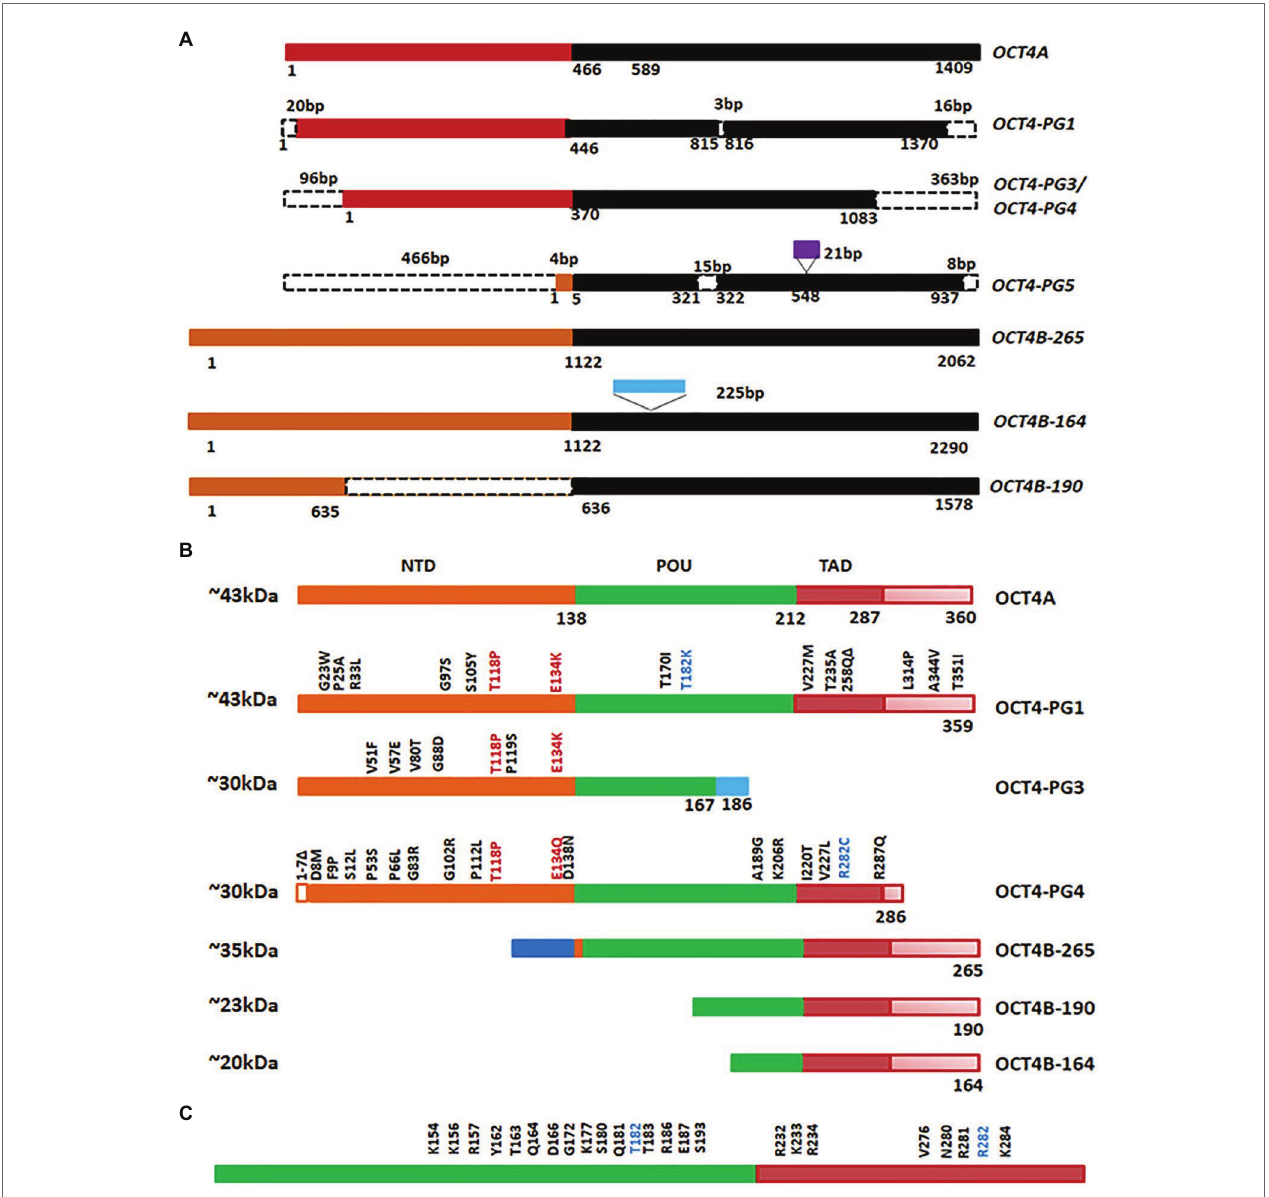
FIGURE 5 | Octamer binding transcriptional factor 4 (OCT4) variants in cancer. (A) The different isoforms and pseudogenes of OCT4 expressed in cancer at the RNA level. The conserved regions are shown in the same color. The dotted lines indicate absence of the region. The sequences inserted are shown in purple or blue boxes. (B) Protein expression of the variants. Conserved amino acid stretches are shown by the same color. The point mutations in the pseudogenes are shown in the figure. (C) The important residues of human OCT4A (POU and TAD domain) that are critical for